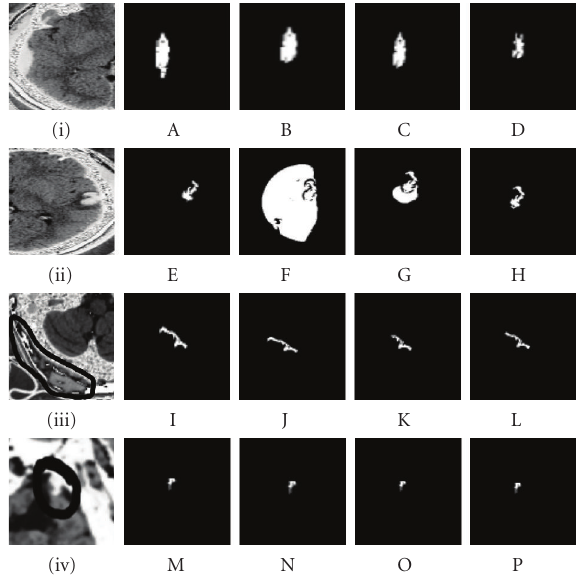
Figure 1: (A, E, I, M) α = − 0 . 0005, β = 0 . 0005, sigma = 0 . 0005, (B, F, J, N) α = − 0 . 0015, beta = 0 . 0025, σ = 0 . 0125, (C, G, K, O) α = − 0 . 375, β = 0 . 2255, σ = 0 . 0225, (D, H, L, P) α = − 0 . 575, β = 4 . 00, σ = 0 . 0325 are (i) values set for subdural haematoma, (ii) contrecoup contusion, (iii) extracranial haematoma, and (iv) brain atrophy by fast marching.